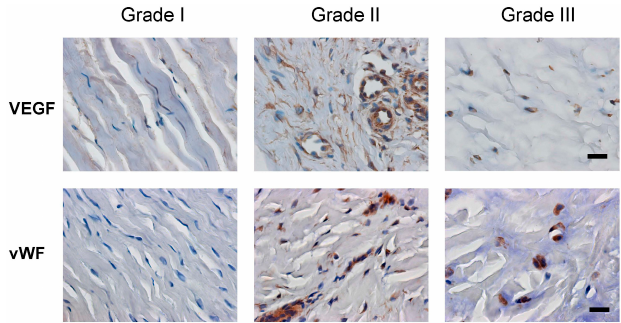
Figure 5. VEGF expression and vessel density in tissue samples of retinaculum were dependent upon disease severity. Serial sections of three grades (I–III) were stained with vascular endothelial growth factor (VEGF) and Von Willebrand’s factor (vWF) antibodies. More blood vessels were distributed in the grade II and grade III tissues of retinaculum (immunohistochemical staining, 400 ˆ magnification, scale bar = 10 µ Table 2. Comparison of the inflammatory and angiogenic factors change among three grades.